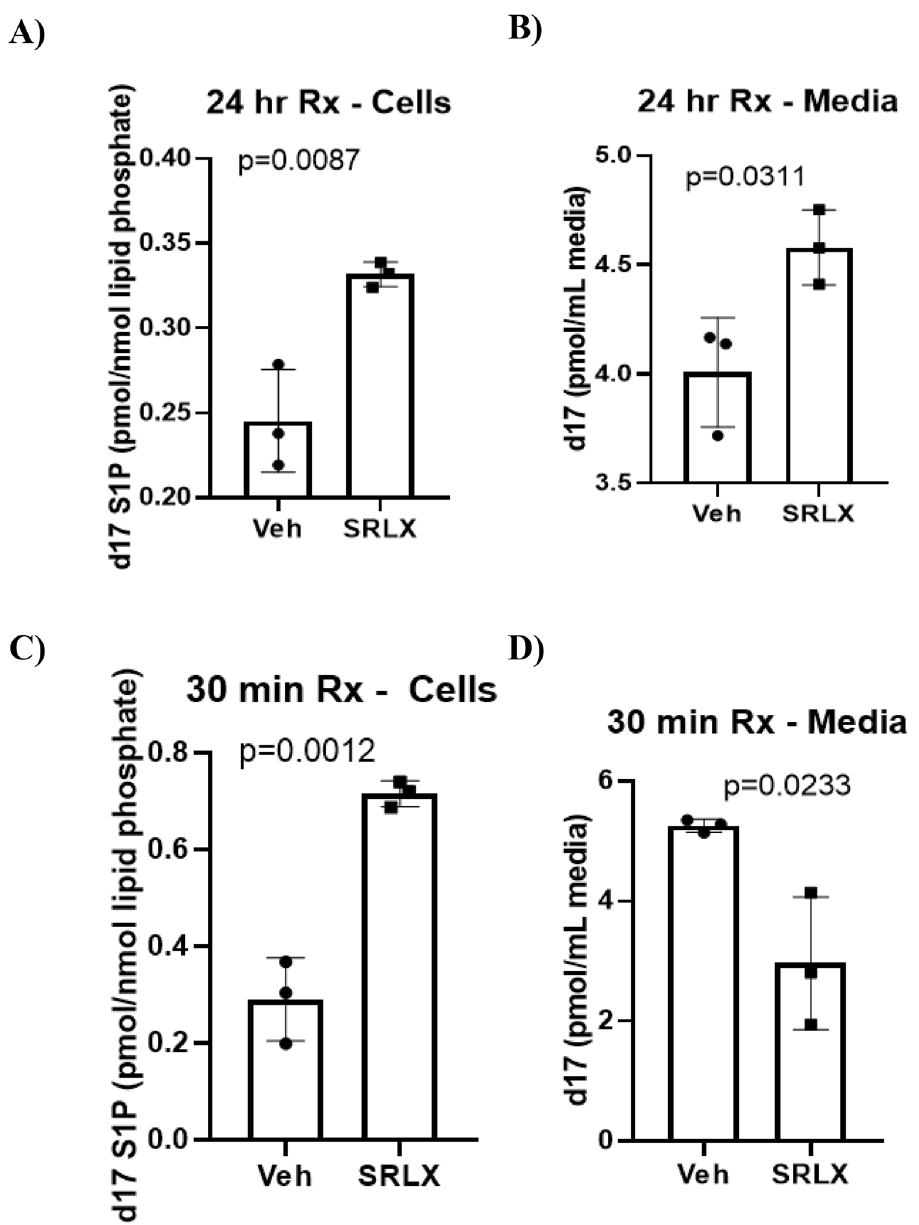
Figure 1. In vitro assessment of SphK1 activity in cardiomyocytes. ( A , B ) Media isolated from cardiomyocytes after the d17 sphingosine assay shows increased d17-S1P levels in cardiomyocytes (0.3317 ± 0.004, vs. 0.245 ± 0.017 pmol/nmol lipid phosphate in control) and media (4.57 ± 0.09 vs. 4.00 ± 0.15 pmol/ml media in control) upon treatment with serelaxin for 24 h ( C ) Co-incubation of cardiomyocytes with d17 sphingosine and serelaxin for 30 min leads to increased d17 S1P levels in the cells (0.716 ± 0.015, vs. 0.29 ± 0.049 pmol/nmol lipid phosphates in control) ( D ) In contrast to the trend in cells, the d17-S1P levels in the media after 30 min of co-incubation with serelaxin and d17 sphingosine are significantly lower (2.097 ± 0.63, vs. 5.26 ± 0.06 pmol/ml media in control). Unpaired T-test was used for all the analyses (n = 3 for each group in A – D